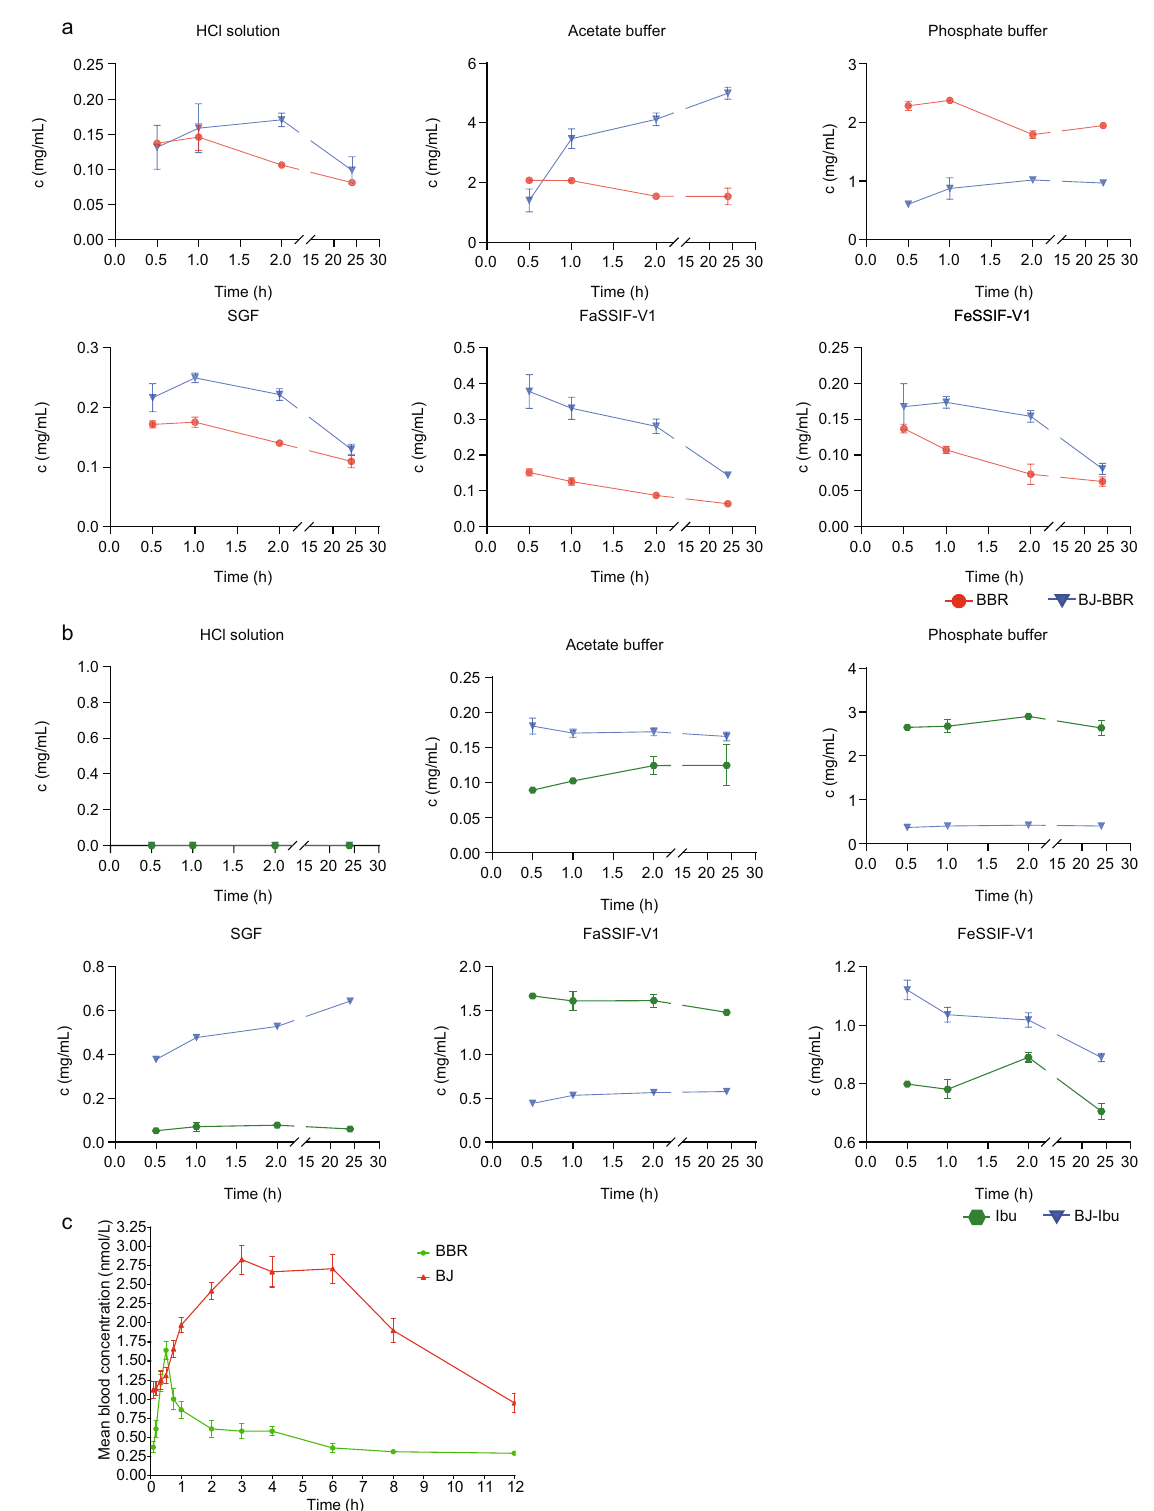
Fig. 2 BJ exhibits better bio fl uid solubility and higher bioavailability than BBR. a Dynamic solubility of BBR (BCl·2H 2 O) and BBR of BJ in six solutions. b Dynamic solubility of Ibu monomer and Ibu of BJ in six solutions. c Mean plasma concentration - time curve of BBR (BCl·2H 2 O) and BBR of BJ in SD rats ( n = 5 per